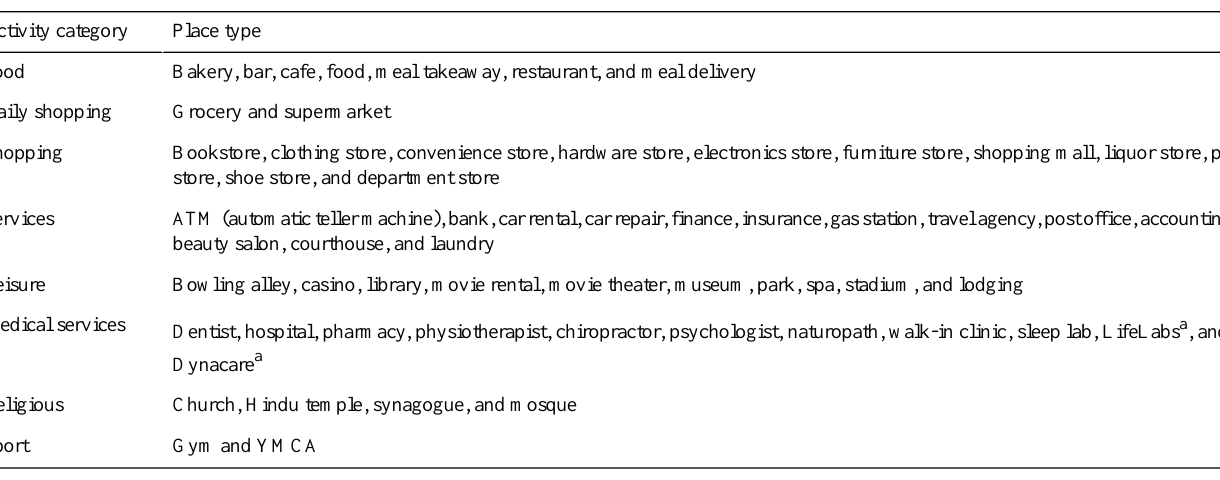
Table 2. Mapping between place types and activities. Place typeActivity category